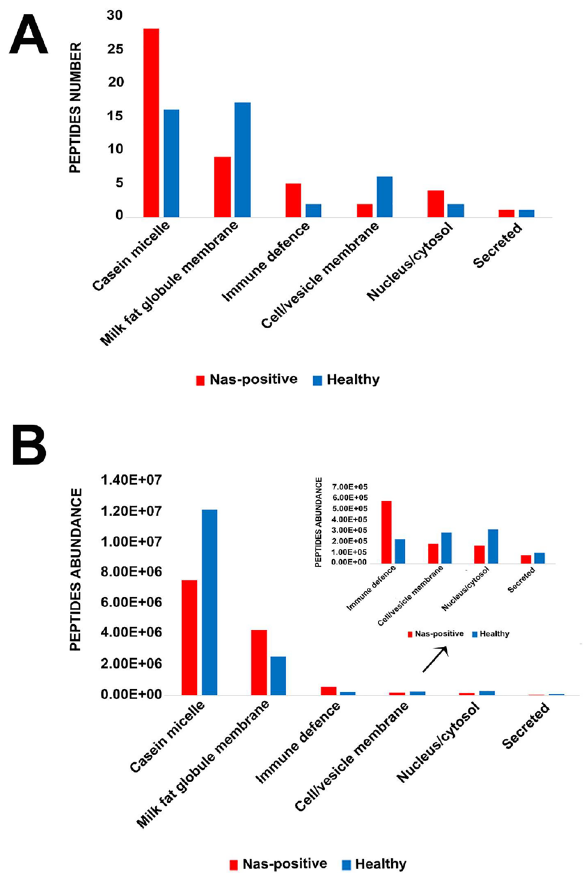
Figure 2. Distribution of the differential peptides identified in NAS-positive (red) and healthy milk (blue) according to the cell location/function of the originating protein. The histograms display the number ( A ) and the abundance ( B ) of peptides in NAS-positive and healthy milk samples, respectively.